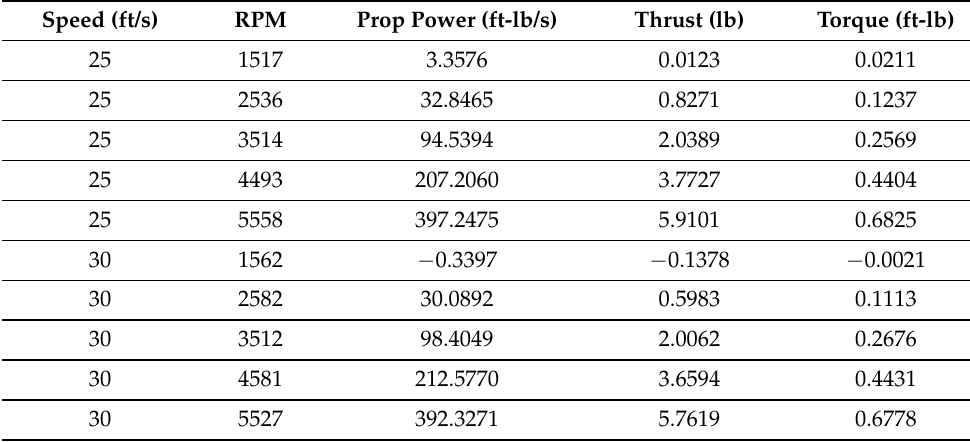
Table A8. APC 16 × 12 propeller wind tunnel raw